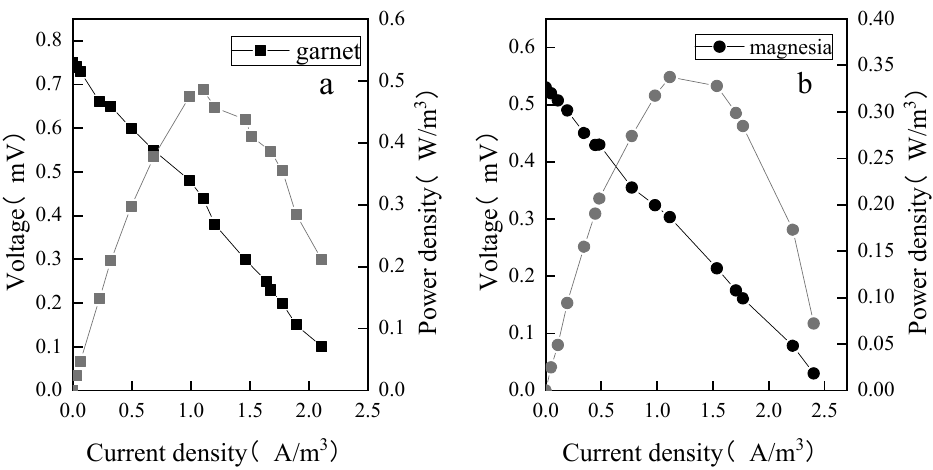
Figure 4. Polarization curve (black curve) and power density curve (grey curve). ( a ) Garnet matrix; ( b ) magnesia matrix.